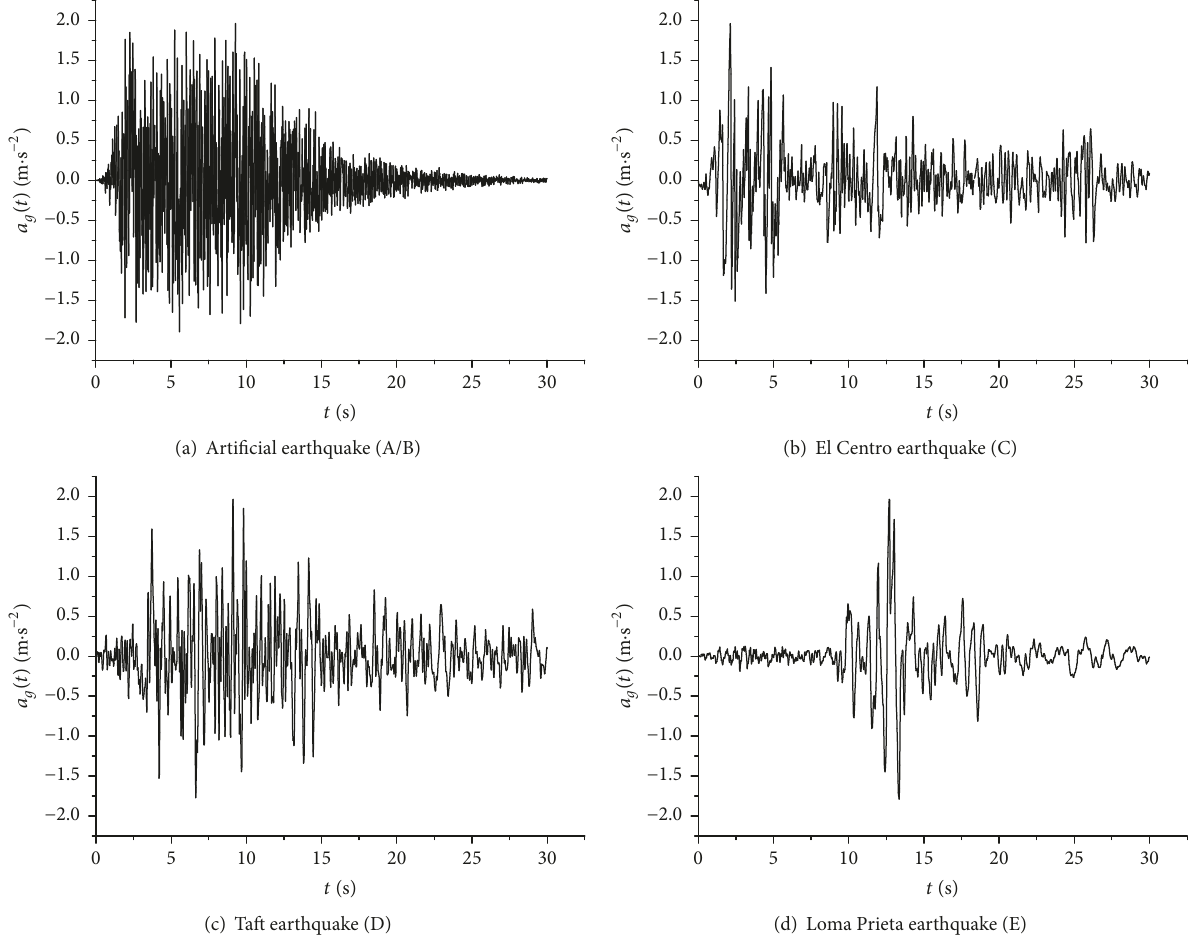
Figure 3: Time histories of four selected earthquake records.